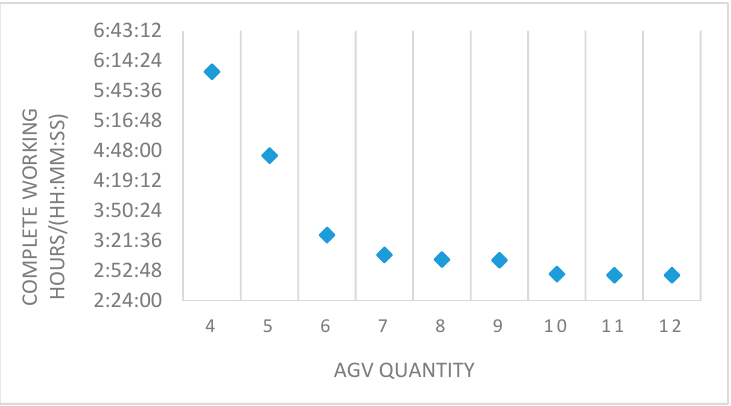
Figure 14. AGV quantity and completion time map.